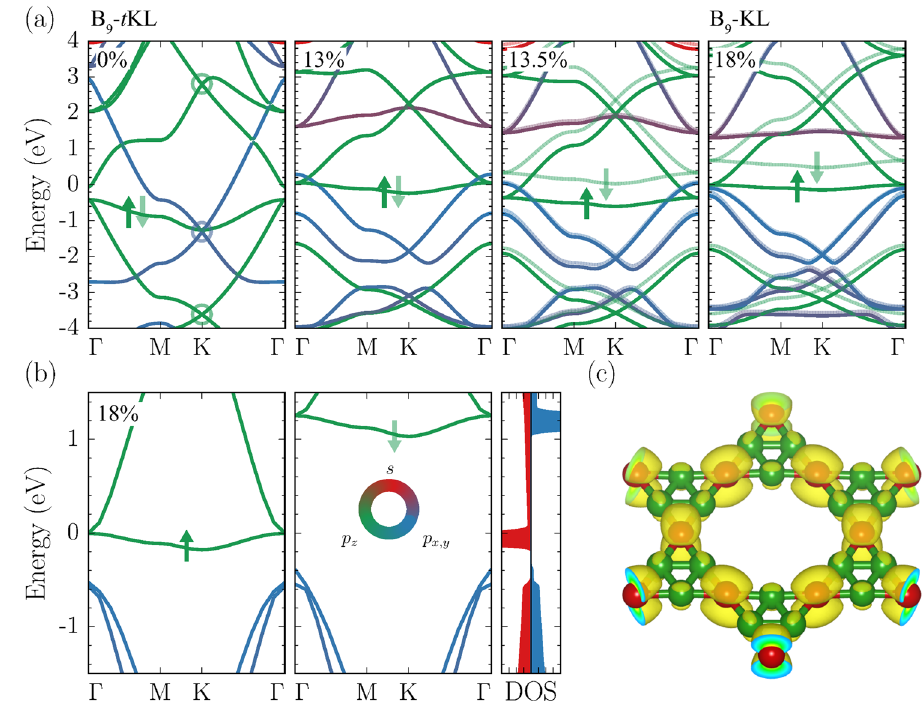
Figure 5. Band structure evolution under strain. ( a ) The PBE band structures of B 9 - t KL and B 9 -KL under strain. Circles indicate three Dirac-like bands, and the bands are color-coded according to their orbital characteristics: green for p z , blue for p x and p y , and red for s orbitals. The spin-down bands are shaded in lighter colors. ( b ) The HSE06 band structure of B 9 -KL for spin-up and spin-down electrons, with the spin-resolved density of states on the right panel. ( c ) The contour plot of the charge density for the flat band near the Fermi level at the K point in B 9 -KL.